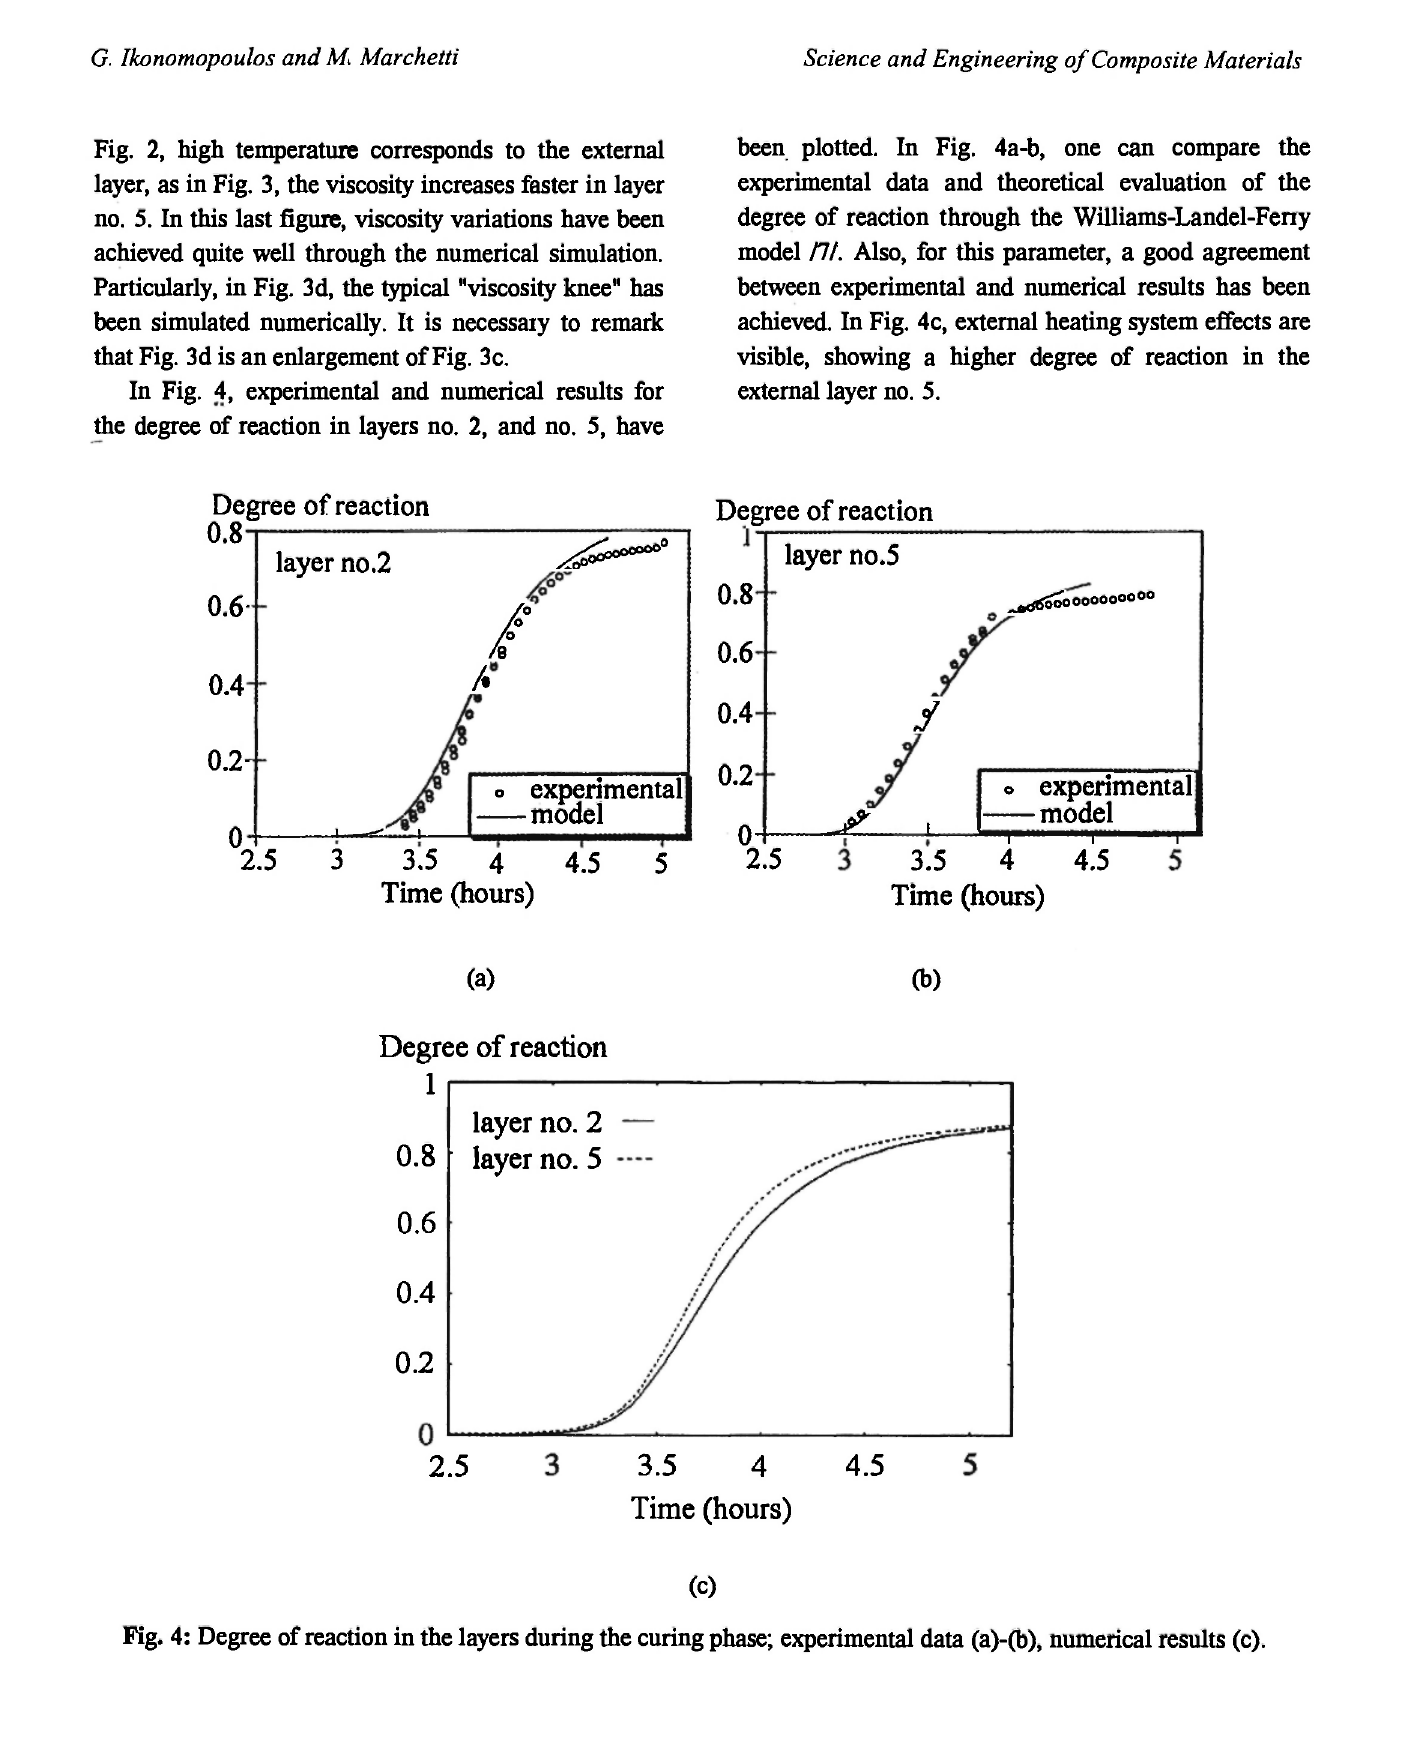
Fig. 4: Degree of reaction in the layers during the curing phase; experimental data (a)-(b), numerical results